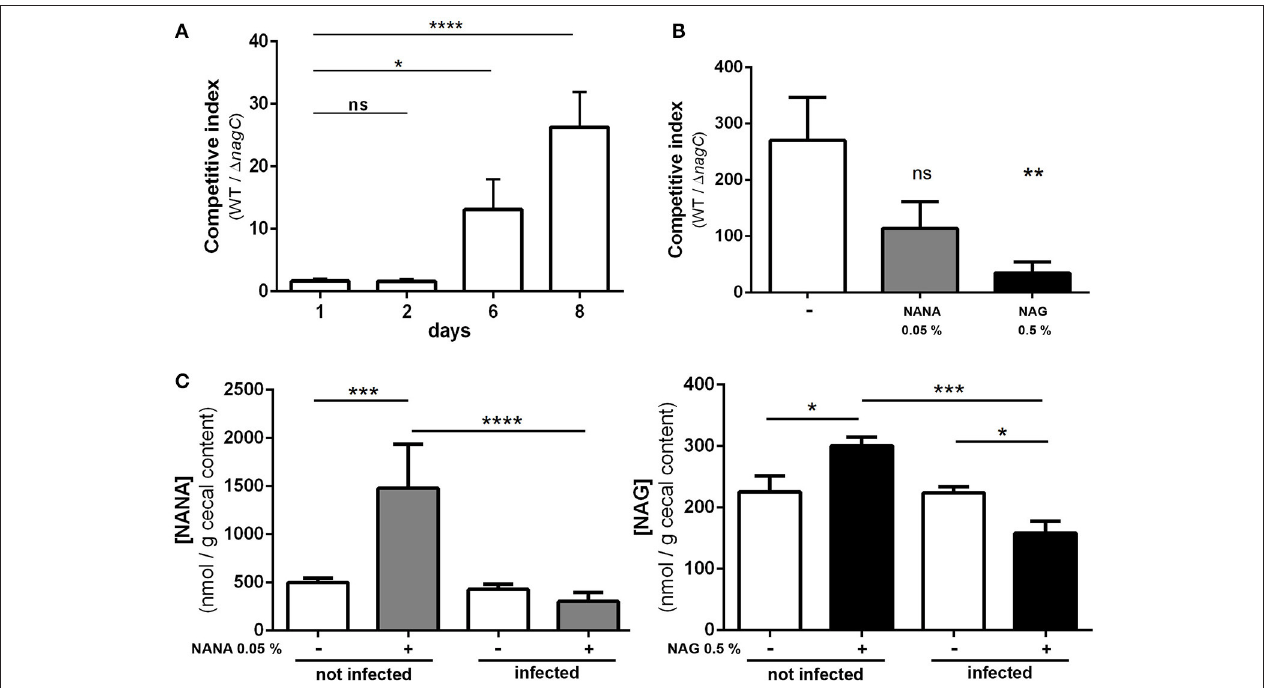
FIGURE 4 | The 1 nagC mutant is outcompeted by the wild type strain during mice infection. Streptomycin-treated BALBc mice were infected with a 1:1 mixture of wild type and 1 nagC EDL933 strains. (A) Wild type and 1 nagC strains were numerated from feces and competitive indices WT/ 1 nagC were calculated at indicated time points. (B) Competitive indices WT/ 1 nagC obtained at day 8 in the cecal contents of mice provided with water with or without NANA 0.05% or NAG 0.5%. (C) Concentration of NANA and NAG in the cecal contents of non-infected mice or EHEC-infected mice provided with or without either NANA 0.05% or NAG